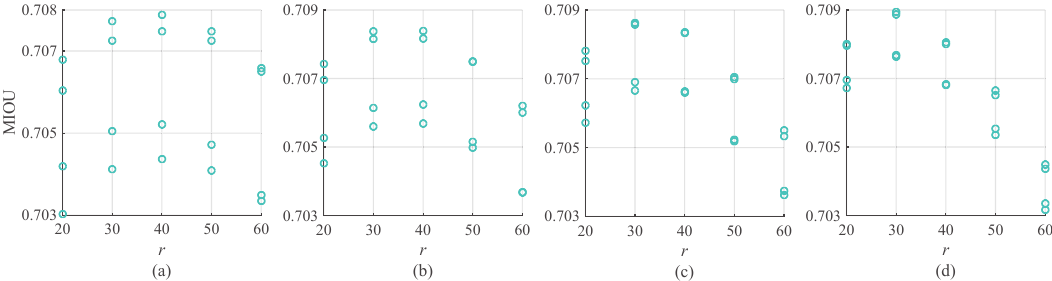
Figure 8. Parameters sensitivity demonstration of the proposed post-processing method combining PSPNet. ( a ) is the MIOU demonstration when ω 1 = 0.5, σ changes from 5 to 20 with a step size of 5, and r changes from 20 to 60 with a step size of 5. ( b ) is the MIOU demonstration when ω 1 = 0.6, σ changes from 5 to 20 with a step size of 5, and r changes from 20 to 60 with a step size of 5. ( c ) is the MIOU demonstration when ω 1 = 0.6, σ changes from 5 to 20 with a step size of 5, and r changes from 20 to 60 with a step size of 5. ( d ) is the MIOU demonstration when ω 1 = 0.8, σ changes from 5 to 20 with a step size of 5, and r changes from 20 to 60 with a step size of 5.